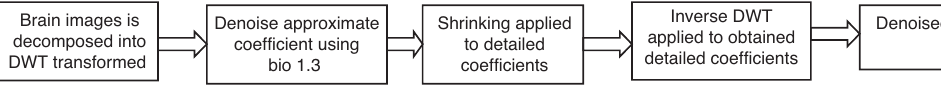
Figure 2: Functional Block Diagram of Denoising Method.